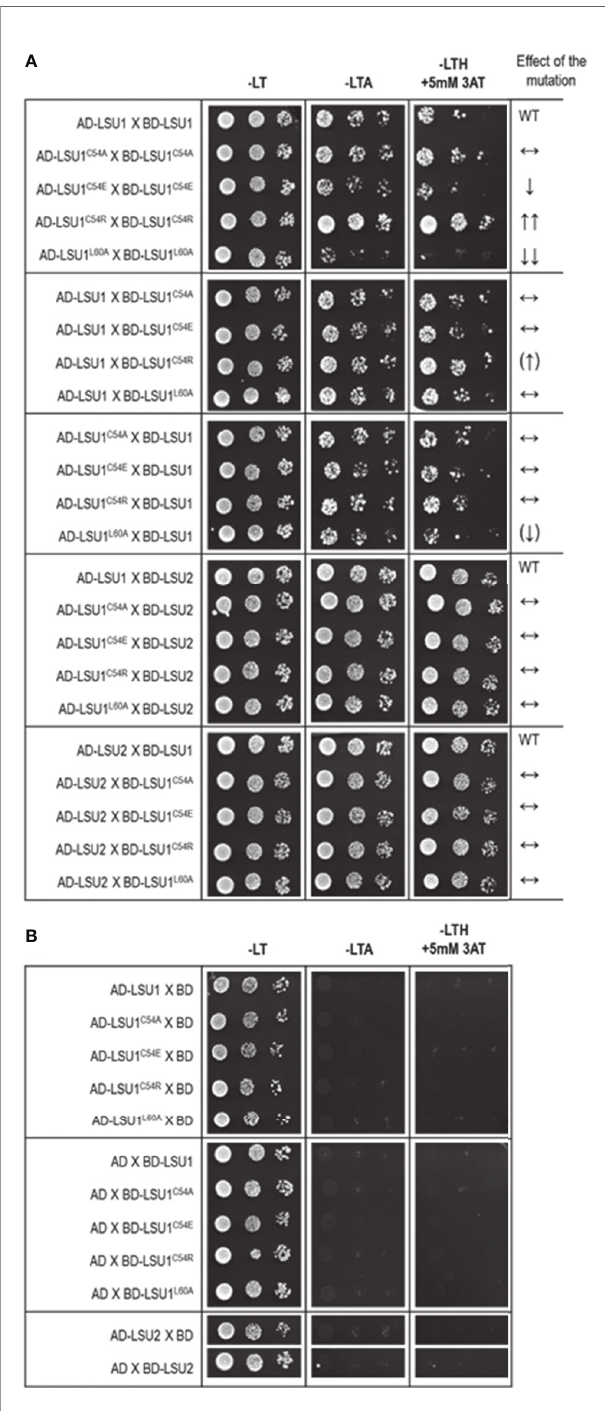
FIGURE 4 | Results of Y2H experiment used to demonstrate the effects of targeted mutagenesis of LSU1 protein on LSU – LSU dimers formation (A) and the respective controls (B) . The effect of the mutations on dimerization is indicated on the right WT, interaction between the wild type monomers (used as a respective reference), ↔ , no effect of the mutation on dimerization; ↓ , reduced binding; ↓↓ , strongly reduced binding; ↑↑ , strongly increased binding; the ( ↑ ) and ( ↓ ) mark the very weak effects — a tendency towards increase and decrease of binding,